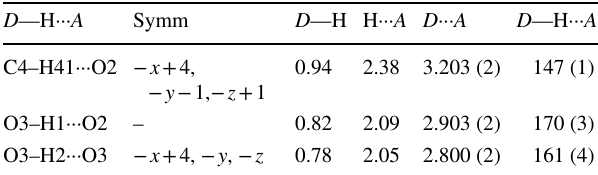
Table 3 Intermolecular interaction distances (Å) for